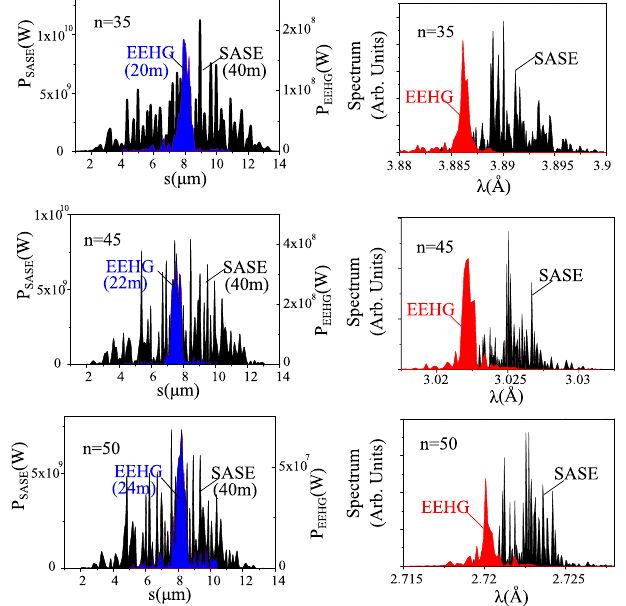
Babzien,FIG. 4. SASE (black) and EEHG (red) power and spectral radiation profile for n ¼ 35 ( R 56 ; 1 ¼ 184 . 7 μ m, R 56 ; 2 ¼ 4 . 86 μ m), 45 ( R ¼ 281 . 6 μ m, R ¼ 6 . 58 μ m), and 50 56 ; 1 56 ; 2 ( R 56 ; 1 ¼ 293 . 2 μ m, R 56 ; 2 ¼ 6 ; 07 μ m). SASE power vs s ¼ ct is on the left axis, EEHG power on the right. Spectra are in arbitrary units and not in With an energy of 3.6 GeV, 1 . 36 × 10 9 photons = shot at 3.02 Å